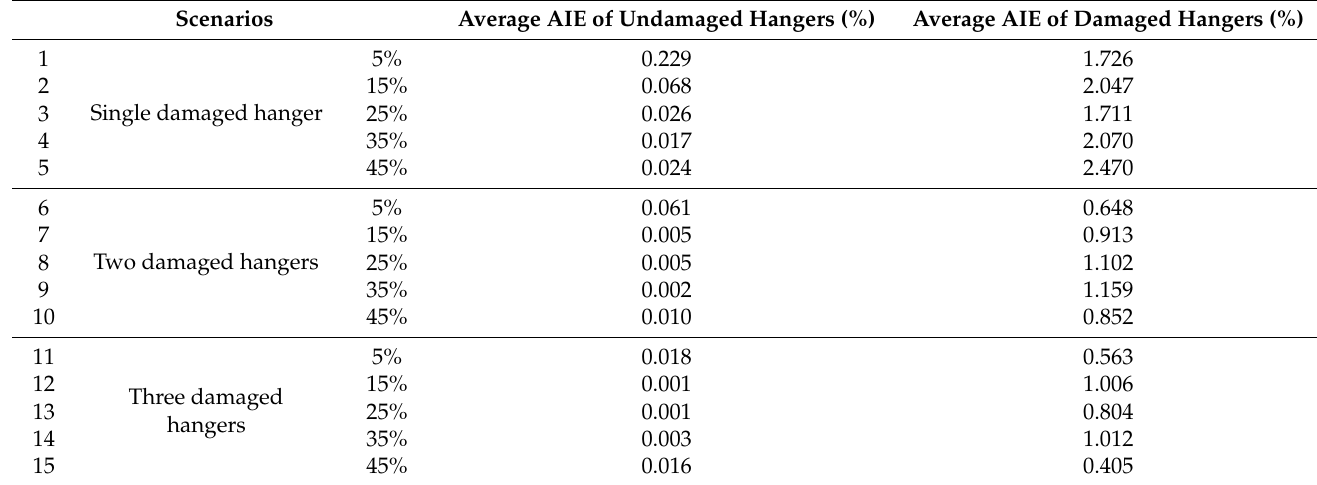
Table 5. AIE of the damage severity of hangers under different damage